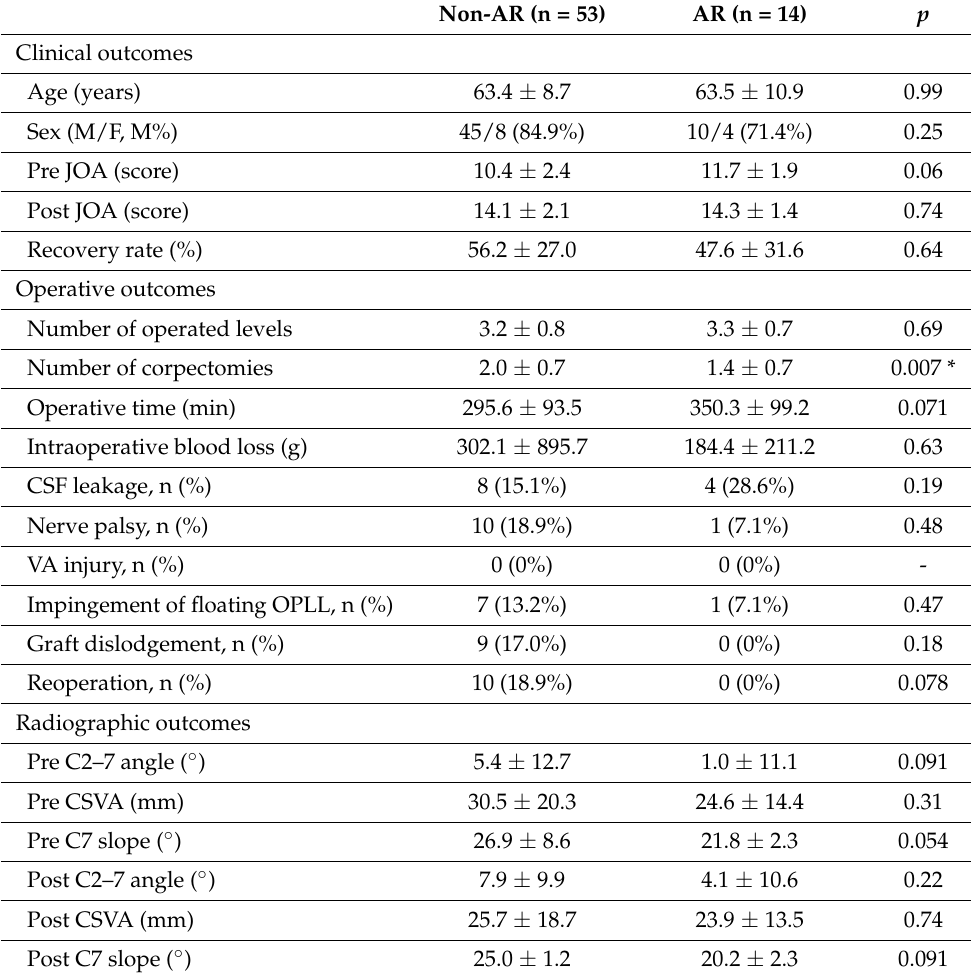
Table 2. Univariate analysis of the patients in the non-AR-supported and AR-supported